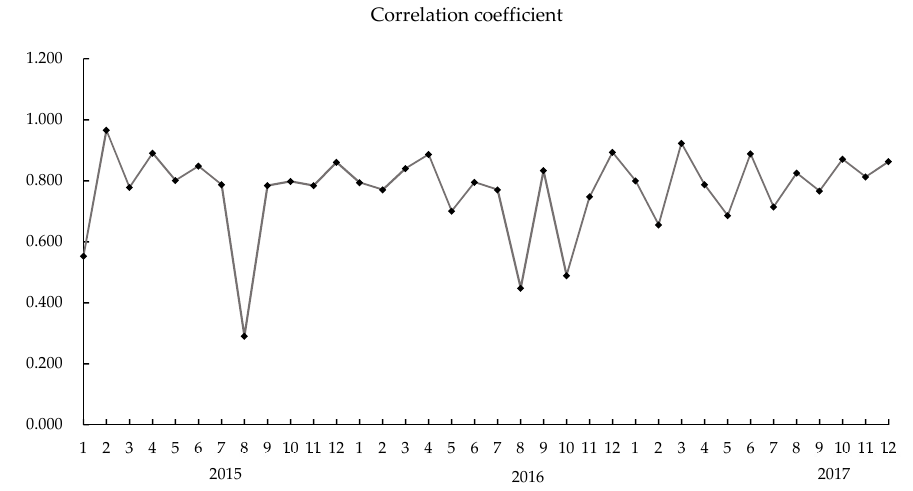
Figure 3. Correlation of precipitation between GPM data and station data.